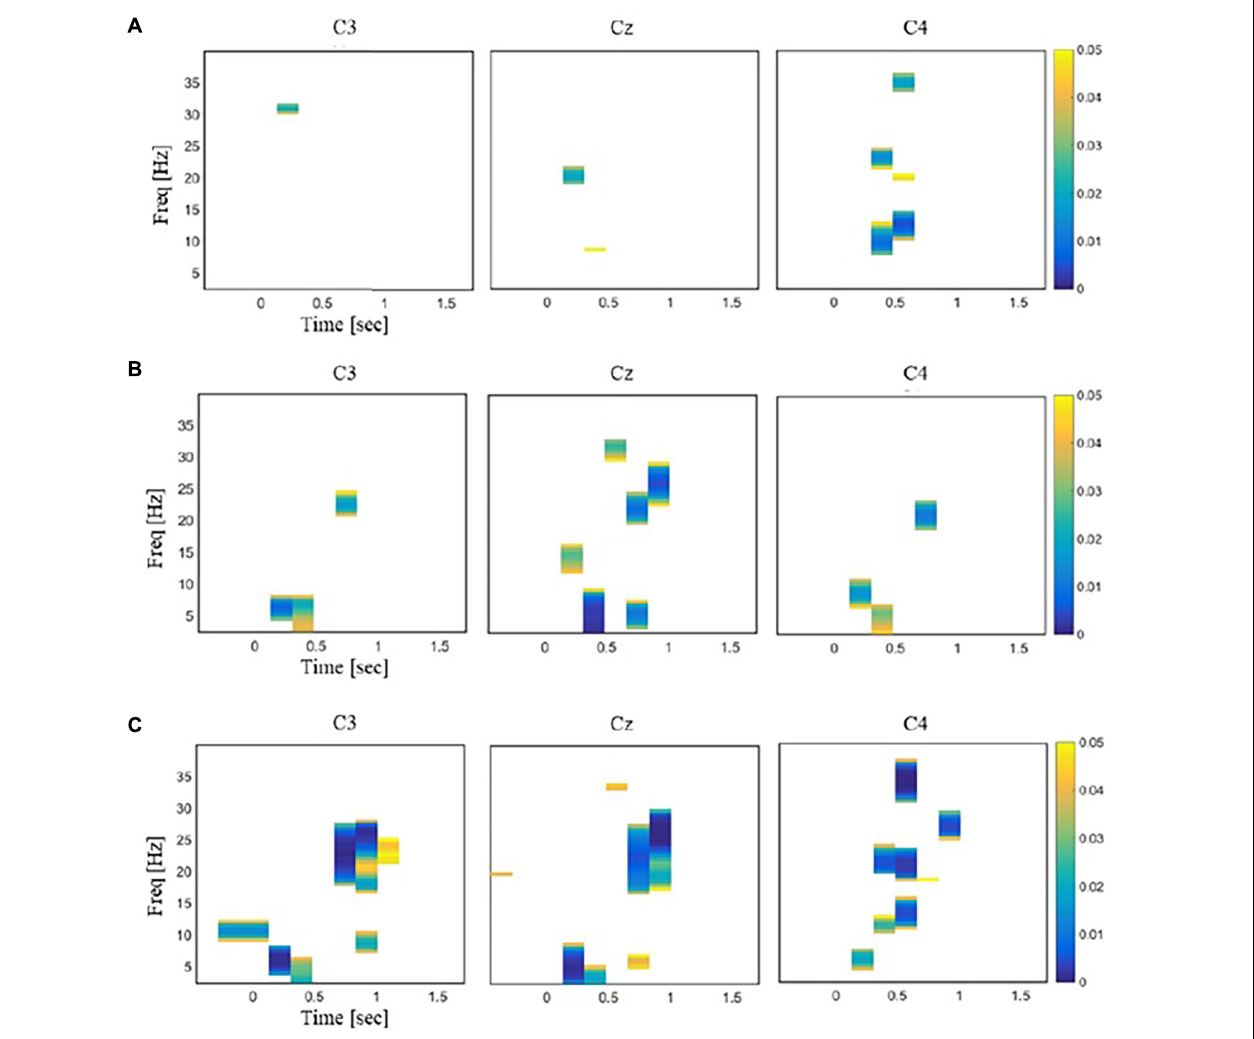
FIGURE 4 | Illustrations of the time–frequency regions in EEG responses that exhibited significant differences between a pair of stimuli [repeated-measures ANOVA (rmANOVA), p < 0.05]. The color bar represents the p values with Bonferroni correction. (A) Comparison between laser and mechanical stimulation. (B) Comparison between laser and sham stimulation. (C) Comparison between mechanical and sham